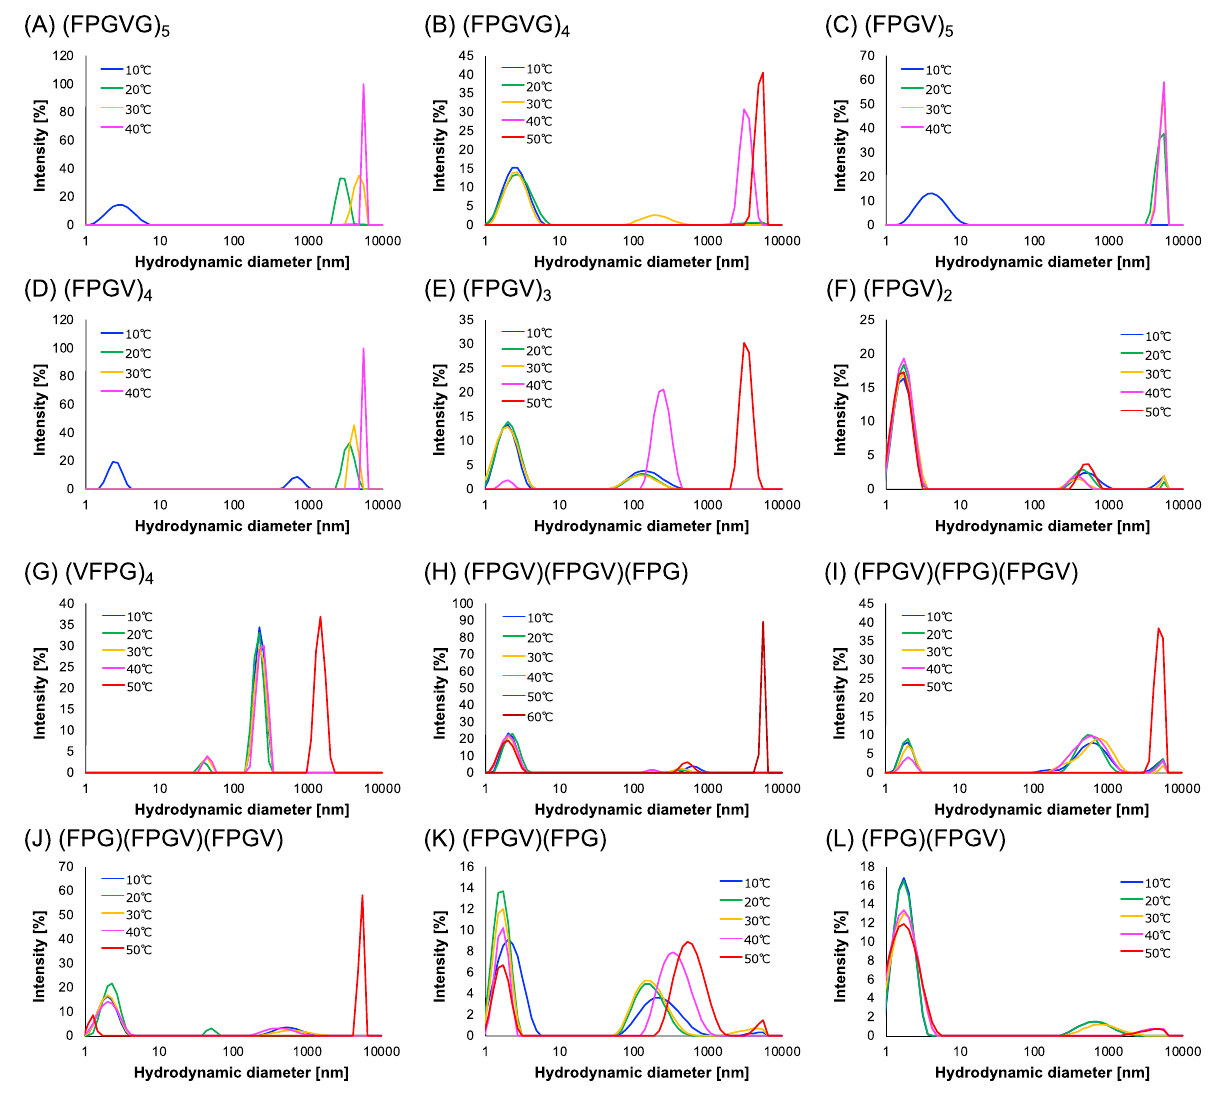
Figure 3. Particle size distribution of the truncated ELP analogues consisting of combinations of FPG and FPGV sequences. The size distribution of the coacervates of the synthesized peptides in phosphate buffer (27.4 mM Na 2 HPO 4 , 17.8 mM NaH 2 PO 4 , pH 7.4) at various temperatures was analyzed via DLS. ( A ) (FPGVG) 5 (10 mg/mL), ( B ) (FPGVG) 4 (10 mg/mL), ( C ) (FPGV) 5 (2.0 mg/mL), ( D ) (FPGV) 4 (10 mg/mL), ( E ) (FPGV) 3 (10 mg/mL), ( F ) (FPGV) 2 (30 mg/mL), ( G ) (VFPG) 4 (10 mg/mL), ( H ) (FPGV)(FPGV)(FPG) (20 mg/mL), ( I ) (FPGV)(FPG)(FPGV) (20 mg/mL), ( J ) (FPG)(FPGV)(FPGV) (20 mg/mL), ( K ) (FPGV)(FPG) (50 mg/mL), and ( L ) (FPG)(FPGV) (50